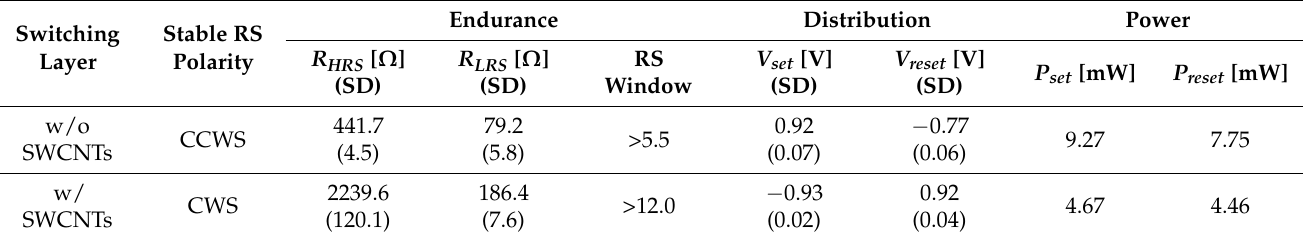
Figure 5. ( a ) Cumulative distribution of the operating voltage and ( b ) operating powers of HSQ memristors w/o and w/ the embedded SWCNT random network. Table 3. Electrical parameters for the RS operating characteristics of the HSQ memristors w/o and w/ the embedded SWCNT random